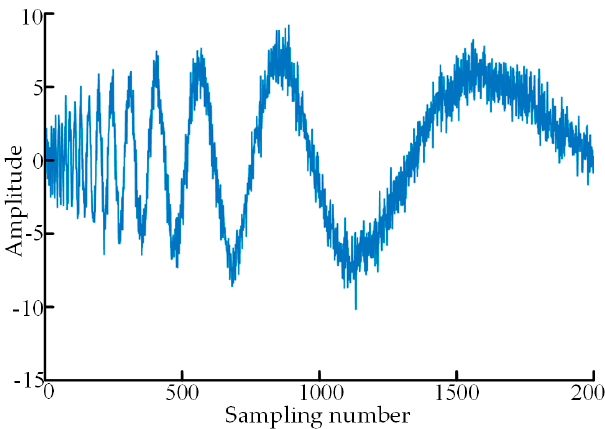
Figure 4. The noisy point cloud data in simulation verification.